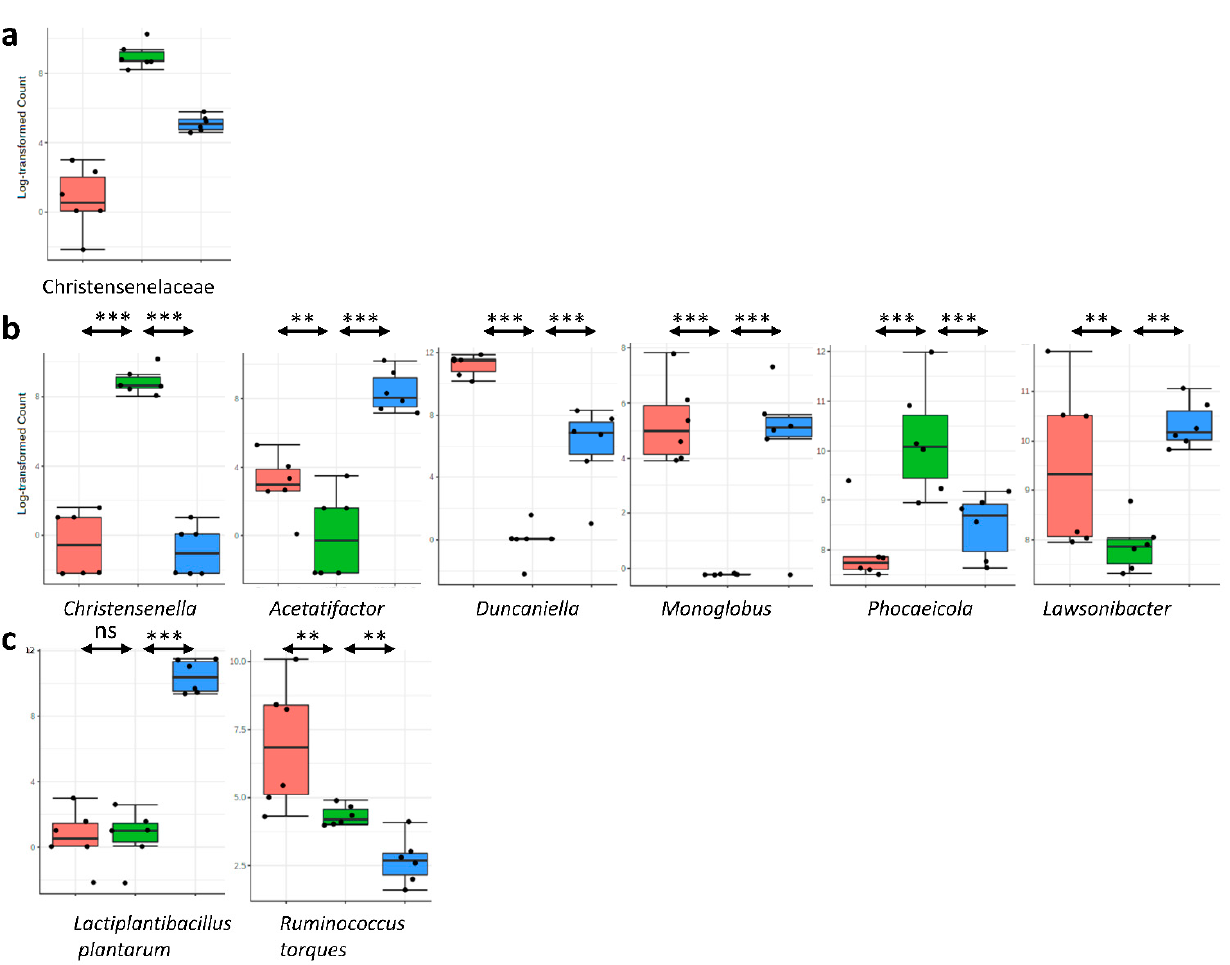
Figure 6. L.p DSM20174 supplementation altered the composition of gut microbiota in HFHF-fed mice. The relative abundance at ( a ) family, ( b ) genus, and ( c ) species levels in the faecal samples from the three groups. Mean values and interquartile ranges are indicated in the plots. ** p < 0.01, *** p < 0.001. Red boxes represent the ND group, green boxes represent the HFHF group, and blue boxes represent the HFHF + L.p group.